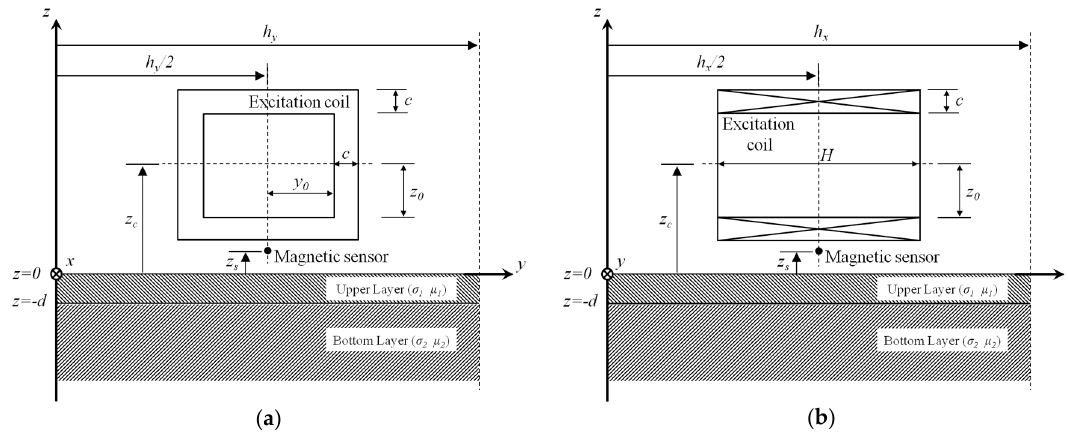
Figure 2. Model of the proposed GPEC probe placed over a two-layer conductor. ( a ) Side view in x -direction; ( b ) side view in y -direction.